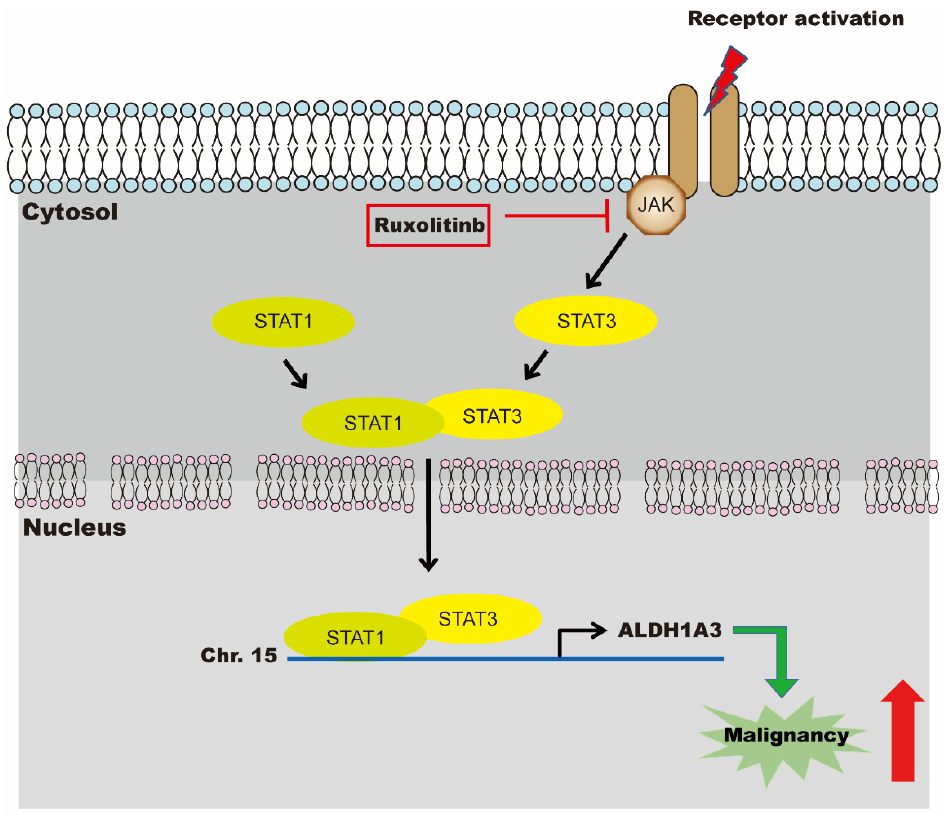
Figure 6. Schematic representation of the effects of ruxolitinib on malignancy of cholangiocarcinoma. A JAK2 inhibitor, ruxolitinib, can downregulate ALDH1A3 expression and inhibit cell proliferation and migration through STAT1/STAT3 in cholangiocarcinoma cell lines.